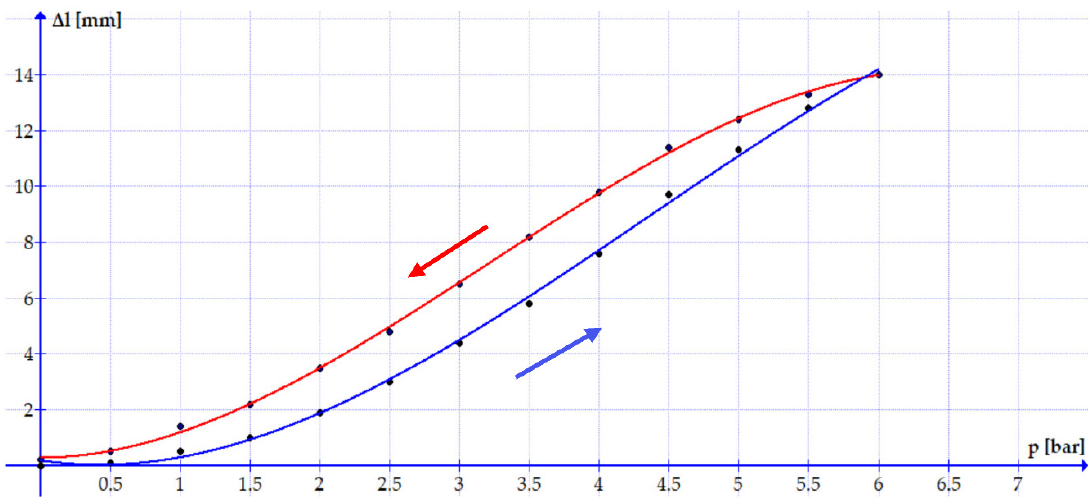
Figure 9. Evolution of the axial contraction versus pressure (M = 4.55 kg). At inflation, with a 4.55 kg mass attached to the free end of the pneumatic muscle, the polynomial regression that best fits the measured data is presented in Equations (5)